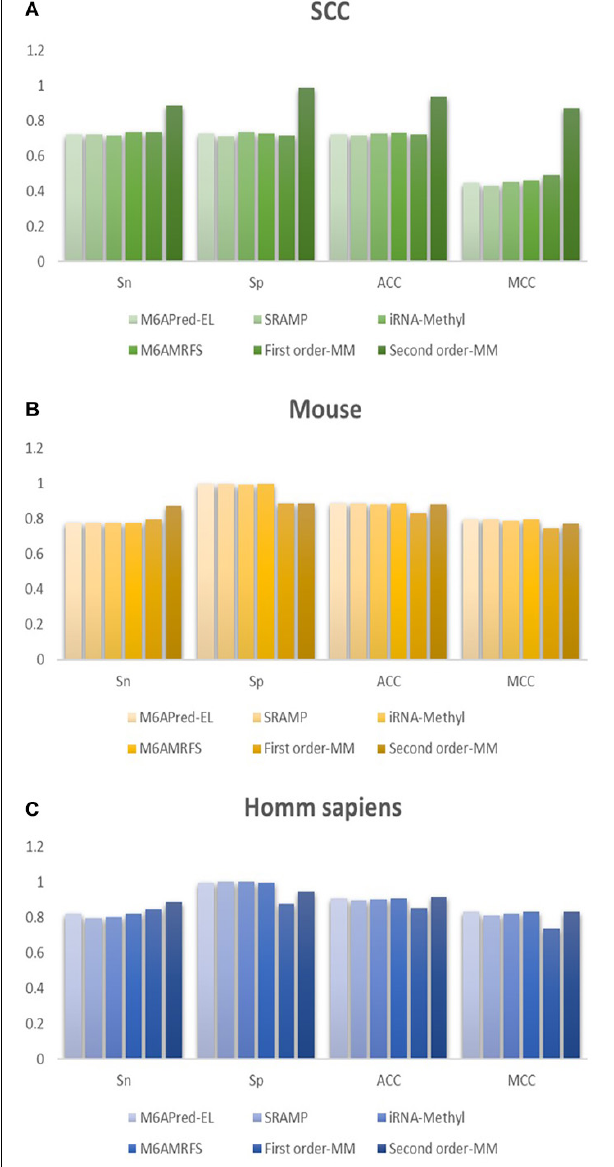
FIGURE 4 | Comparison of the prediction effect of the six methods in (A) S. cerevisiae , (B) mouse, and (C) H.